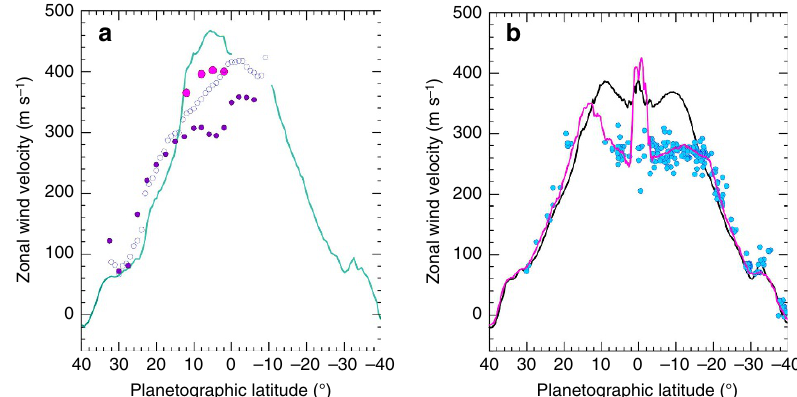
Figure 1 | Saturn’s Equatorial jet in time traced by cloud motions. ( a ) Voyager 1 and 2 in 1980–1981 (turquoise line, ref. 7); Hubble Space Telescope (HST) in 1990–1991 in the 889nm methane absorption band (violet filled circles) and in 547nm (empty circles) corresponding to the development of the 1990 GWS 20 ; Ground-based historical GWS storms in 1876, 1933 and 1990 (magenta dots) 22 . ( b ) Cassini ISS in 2004-09 in the methane band at 889nm (magenta line, refs 9,13), and in 752 and 939nm (black line, refs 9,13); HST in 1994–2003 in the 889nm methane band (blue dots) 11